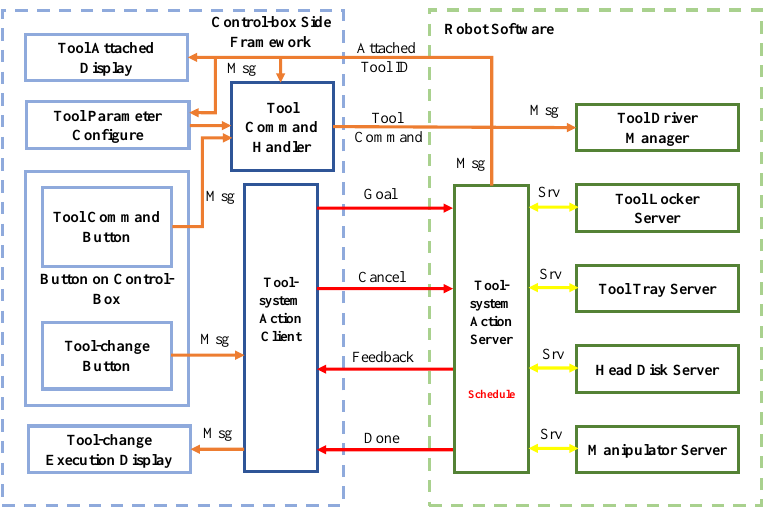
Figure 9. Block diagram of the automatic tool replacement